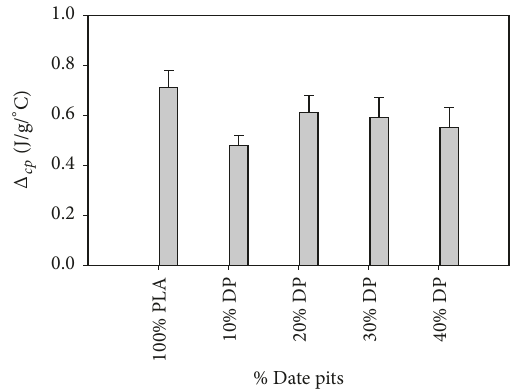
Figure 3: Effect of date pits on Δ𝐻 of PLA glass transition.